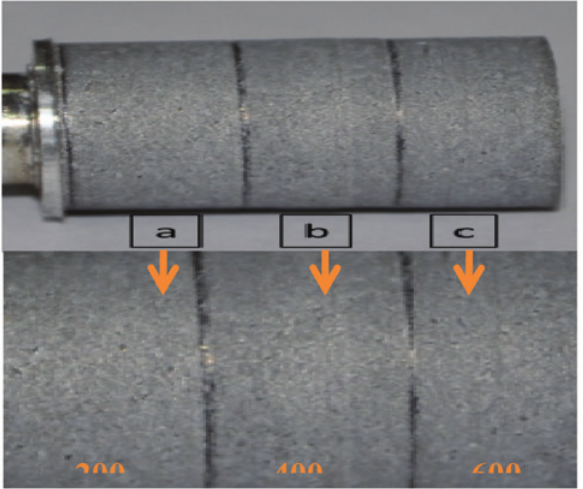
Figure 5: Wire EDM-turned sample.